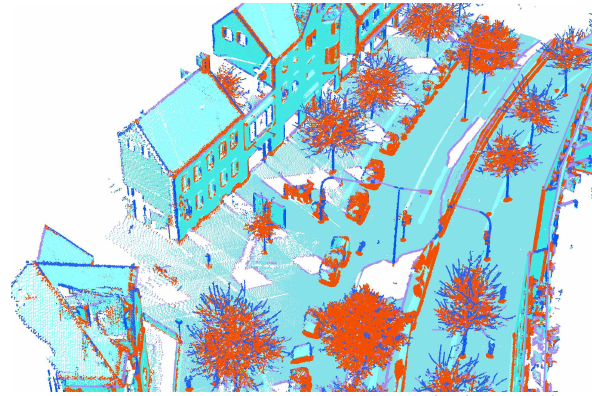
Figure 2. Raw classification into volumetric (red), linear (dark blue) and planar (light blue) patterns using a 50 cm radius